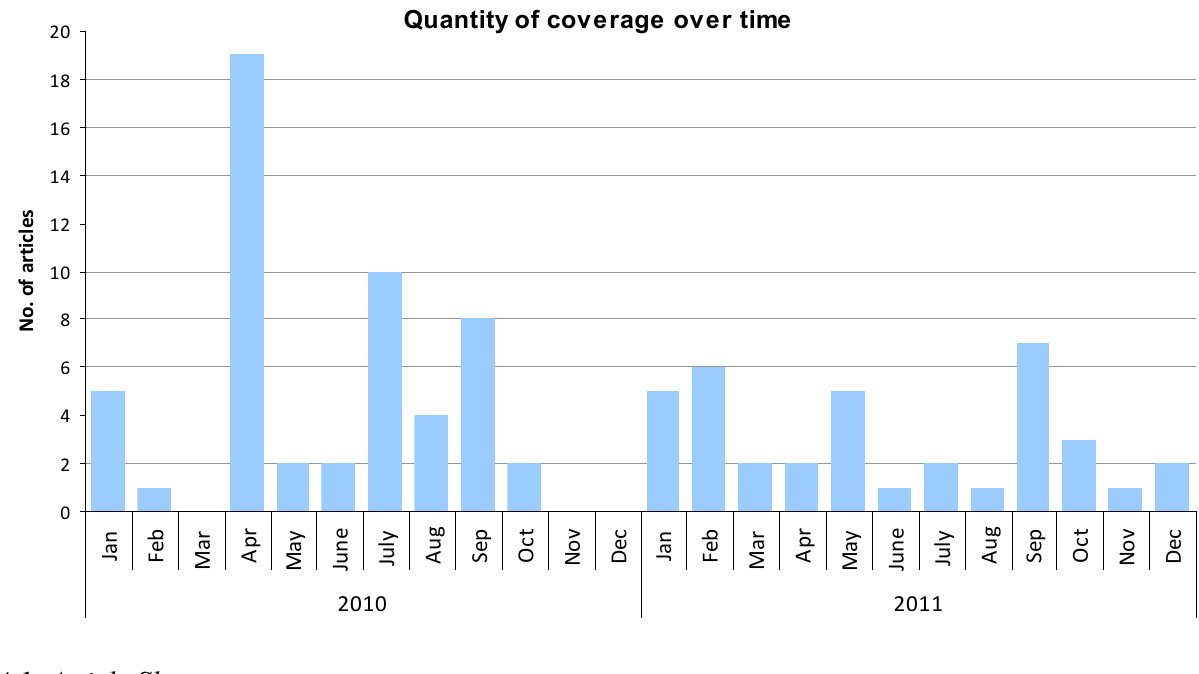
Figure 1. Quantity of coverage over